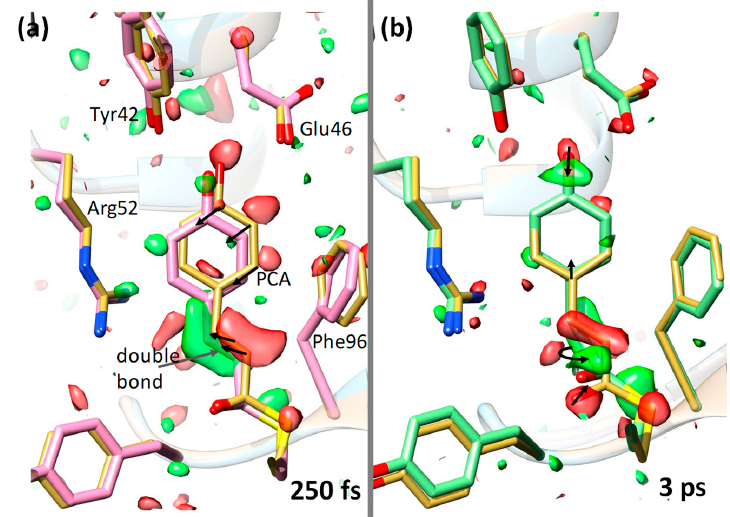
Figure 3. Ultrafast structural changes in the chromophore pocket of PYP [5] Green represents a positive difference electron density and red a negative difference electron density (on the 3/ ‐ 3 σ contour level). Yellow structure represents a reference (dark state) structure. The p ‐ coumaric acid (PCA) chromophore as well as some nearby residues are marked. ( a ) 250 fs after laser excitation (pink structure); the chromophore configuration is still trans . Larger structural changes are denoted by arrows. ( b ) 3 ps after laser excitation (green structure); the structure is cis . Isomerization occurred about the double bond (curved arrow) at the chromophore tail. Some structural changes are also shown by arrows.